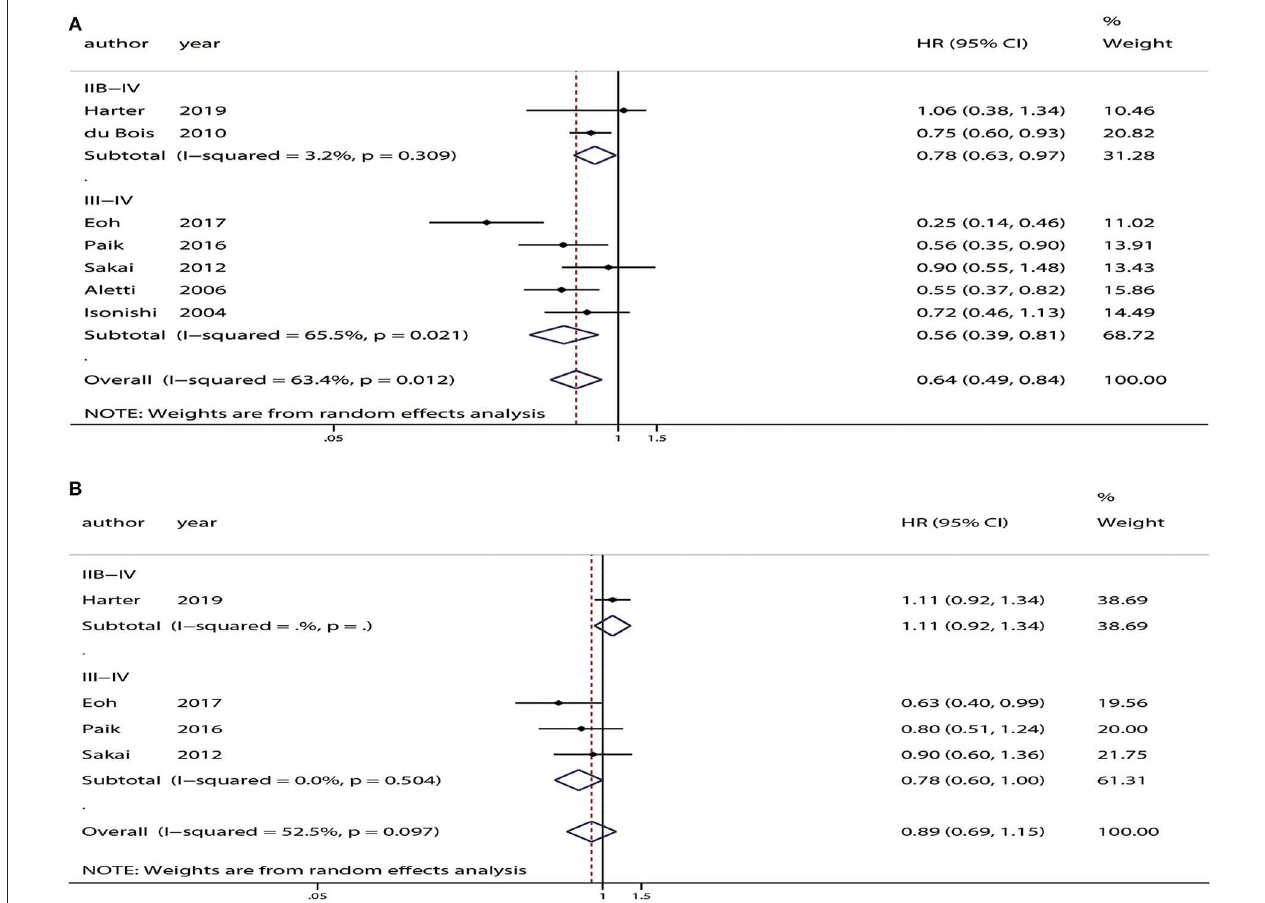
FIGURE 6 | Subgroup analyses based on the International Federation of Gynecology and Obstetrics (FIGO) stage between patients who underwent systematic lymphadenectomy and those who underwent unsystematic lymphadenectomy. (A) Overall survival (OS). (B) Progression-free survival (PFS).